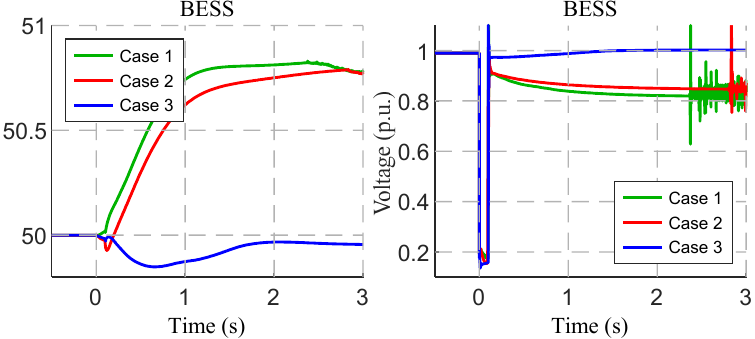
Figure 16. BESS power converter synthetic frequency and terminal voltage for different reactive current-voltage injection profiles.